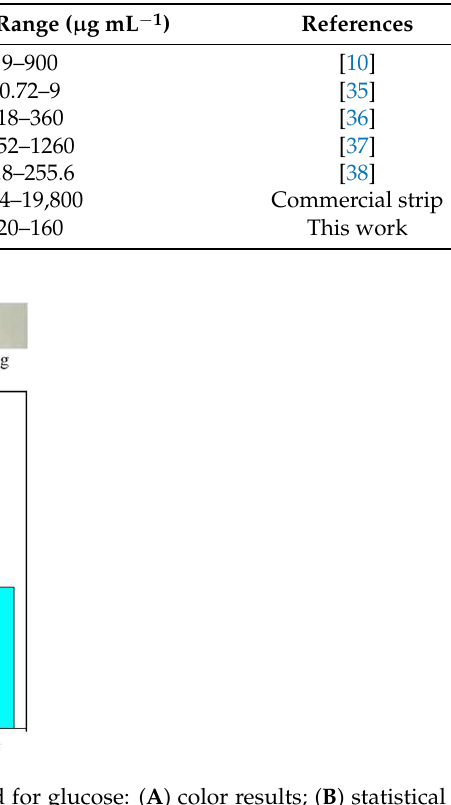
Figure 7. Calibration curve for glucose detection: ( A ) color results; ( B ) calibration curve results. R (red) and B (blue) are RGB color values.